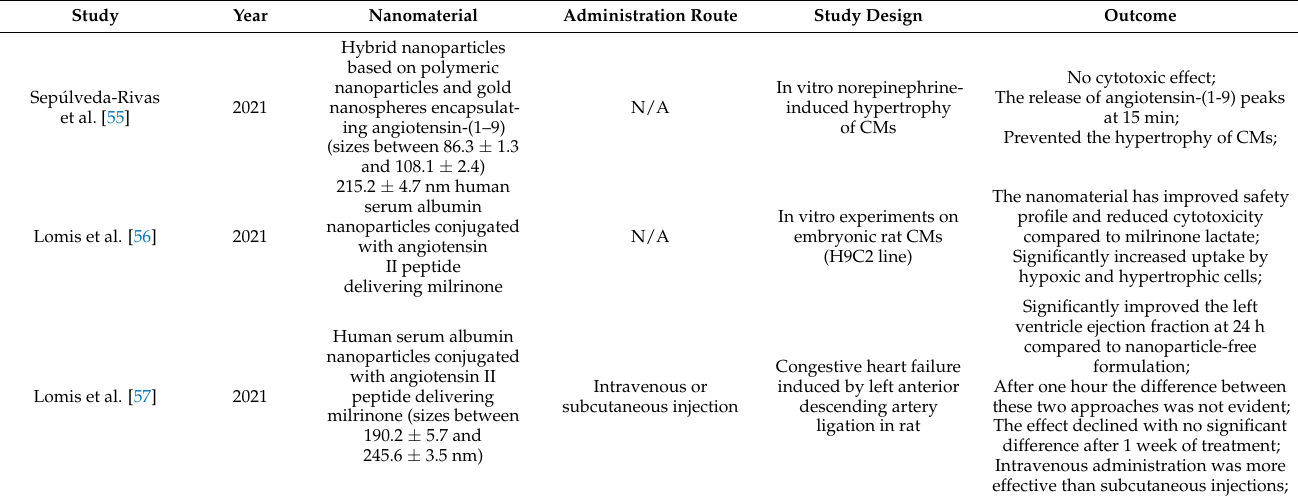
Table 2. Targeting the renin–angiotensin–aldosterone system by